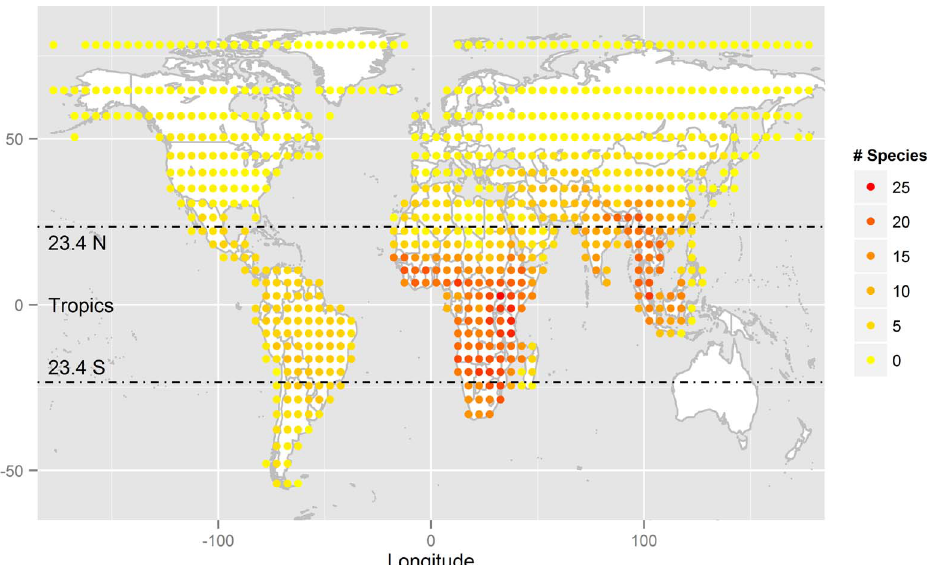
Figure 1. Feliform species richness distribution in a Behrmann Equal Area projection of 5 6 equivalents (482 km 6 482 km) grid size, with the tropics marked.